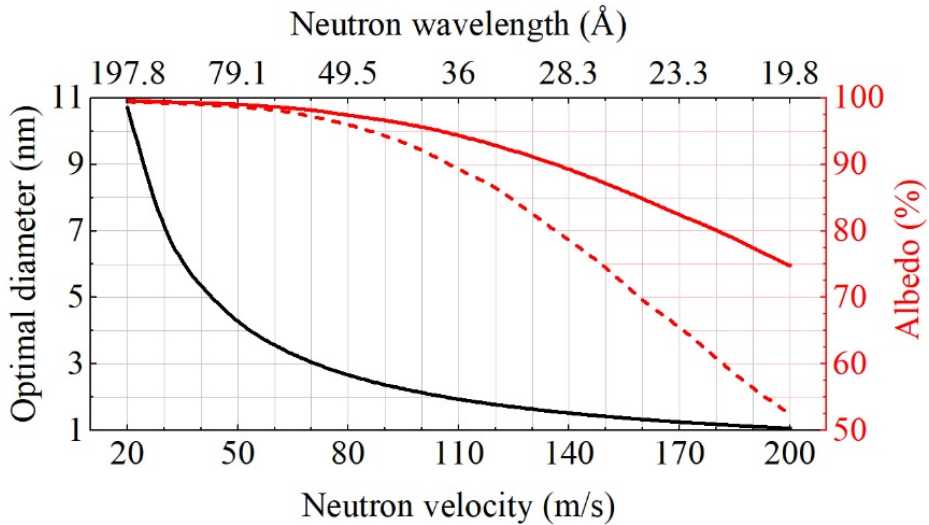
Figure 1. Optimal diameters of diamond nanospheres (black line) as a function of VCN veloc- ity/wavelength. Solid red line shows the corresponding calculated VCN albedo for the optimal diameters of diamond nanospheres. Dashed red line stands for the VCN albedo from real DF-DNDs (see ref. [46]). Neutrons are only absorbed by carbon atoms.